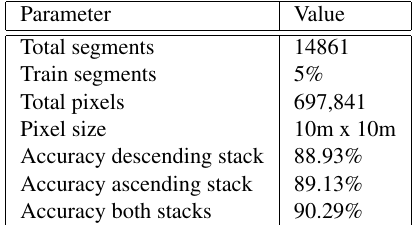
the ground truth, as illustrated in Figure 8. Pixels marked in red are classified as urban while appear as non-urban in the ground truth, maybe due to lack of update of the DUSAF6 dataset. Pix- els marked in blue are the missed detections. It is clear that some areas are labeled urban in DUSAF6 even though they are not cov- ered by an urban structure (i.e., building, road, etc.). Green pixels mark the correctly labeled urban pixels, which closely follow the shapes of the buildings.